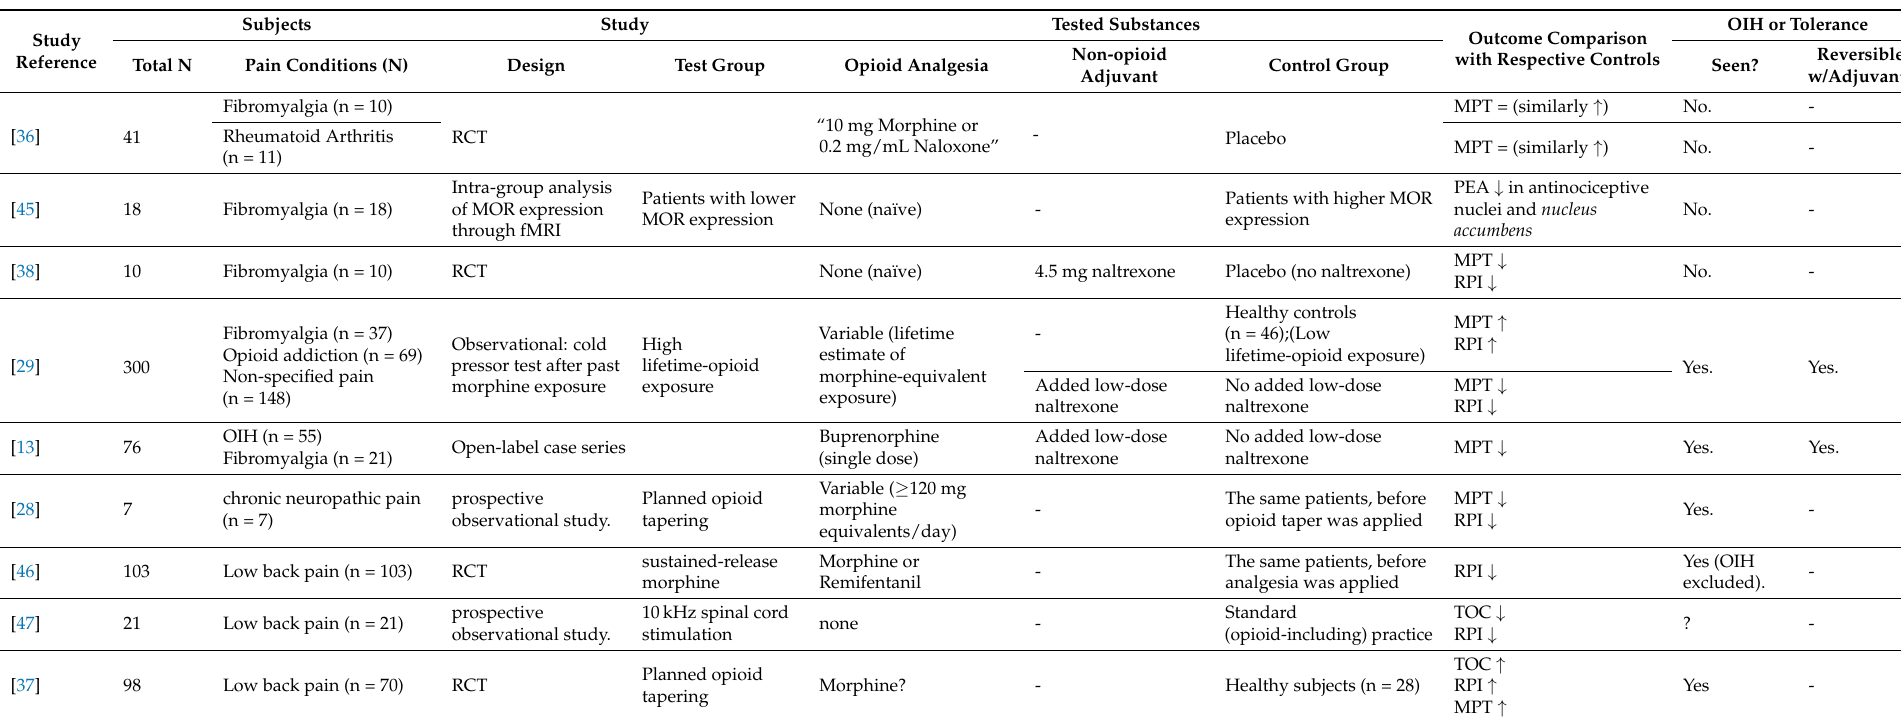
Table 1. Characteristics of relevant studies in the context of chronic opioid therapy: study type, setting, patients and tested